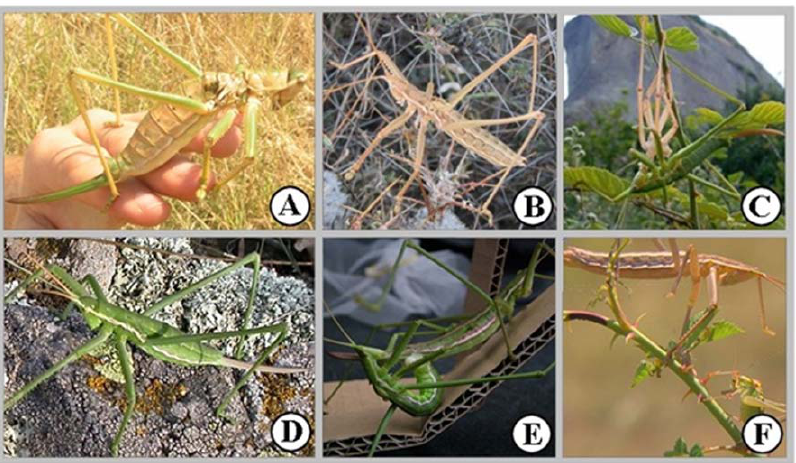
Figure 1. The European Saga species. A) S. natoliae ; B) S. rammei ; C) S. hellenica ; D) S. pedo ; E) S. c. campbelli ; F) S. c. gracilis.